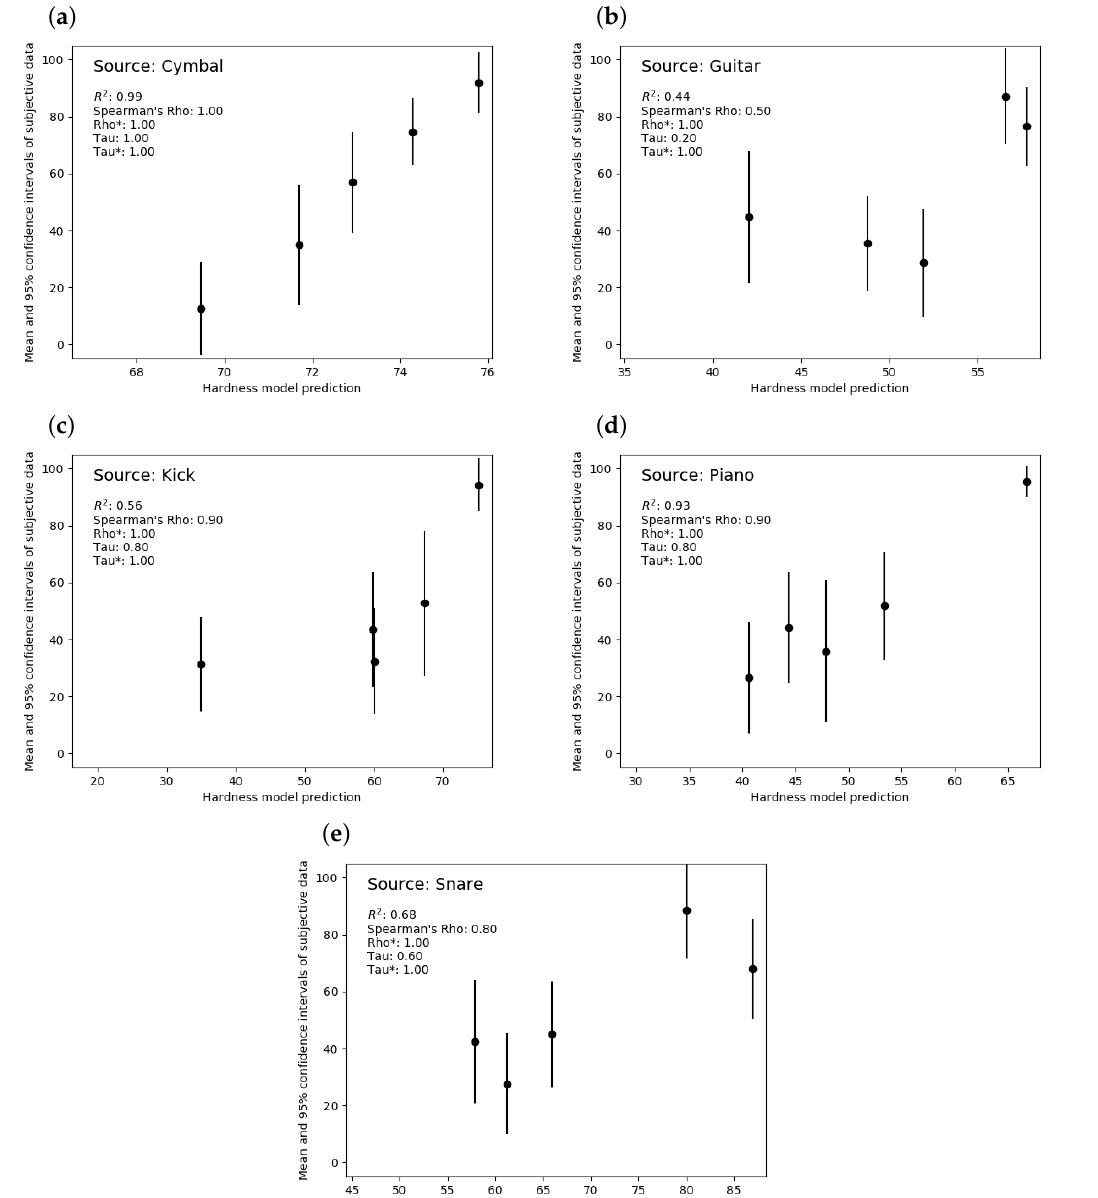
Figure 8. Performance of the hardness model with the within-source-type validation data. ( a ) Cymbal. ( b ) Guitar. ( c ) Kick. ( d ) Piano. ( e )